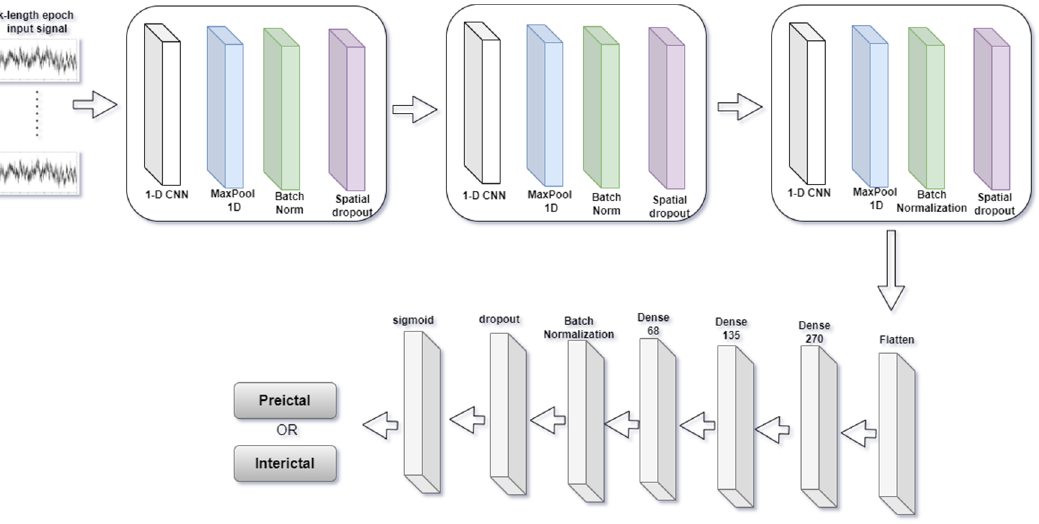
Figure 7. First proposed deep learning model architecture.